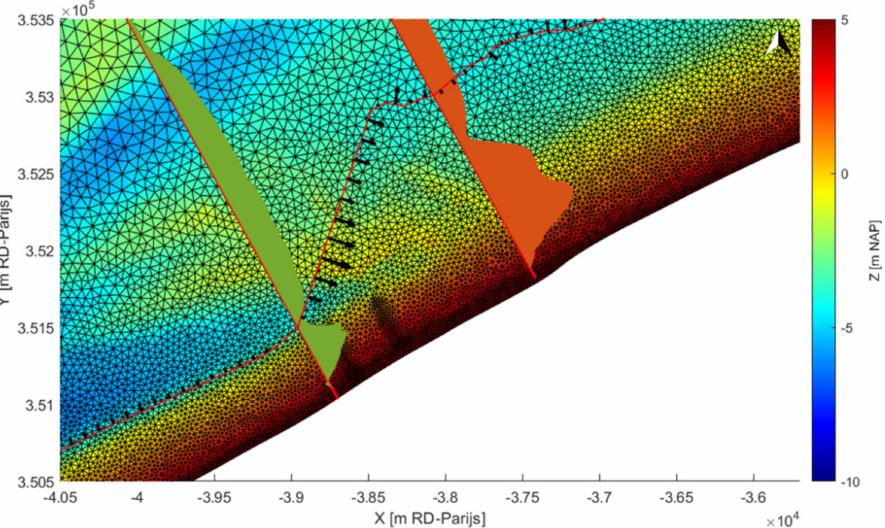
Figure 9. Scaldis-Coast output of sand transport across the seaward boundary of the active beach and shoreface zone in the area of Den Oever (between transects 5 and